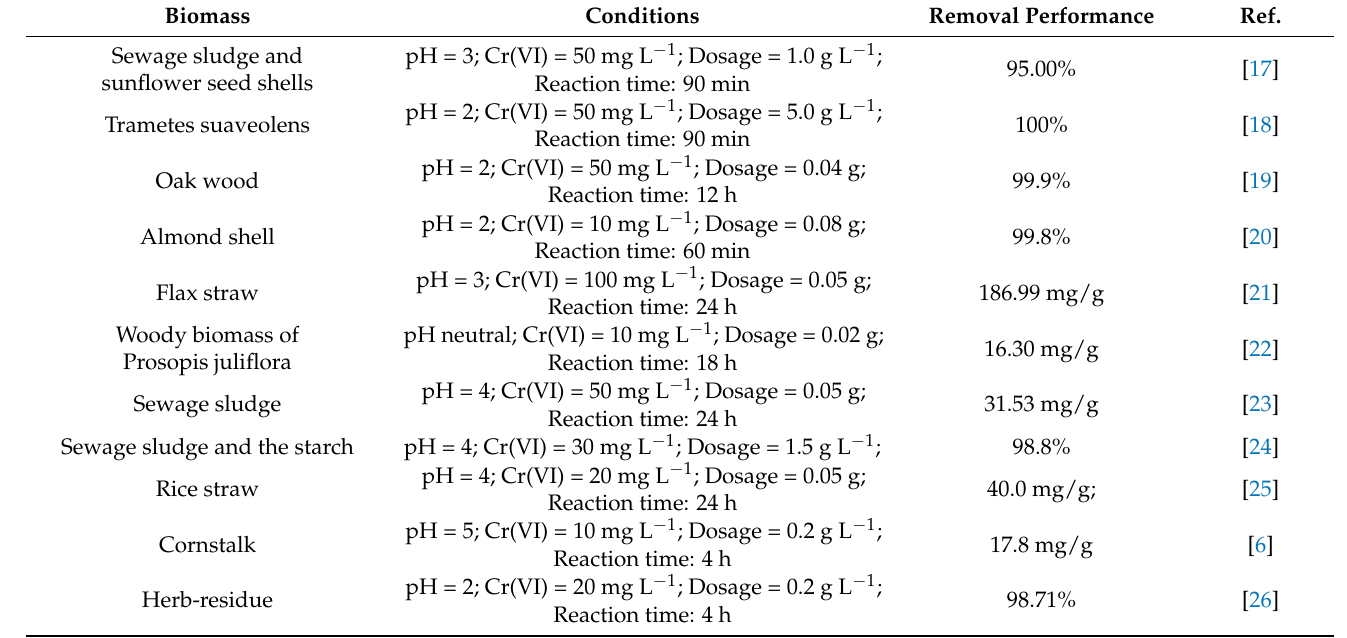
Table 1. Removal of Cr(VI) from aqueous solutions by BC-nZVI